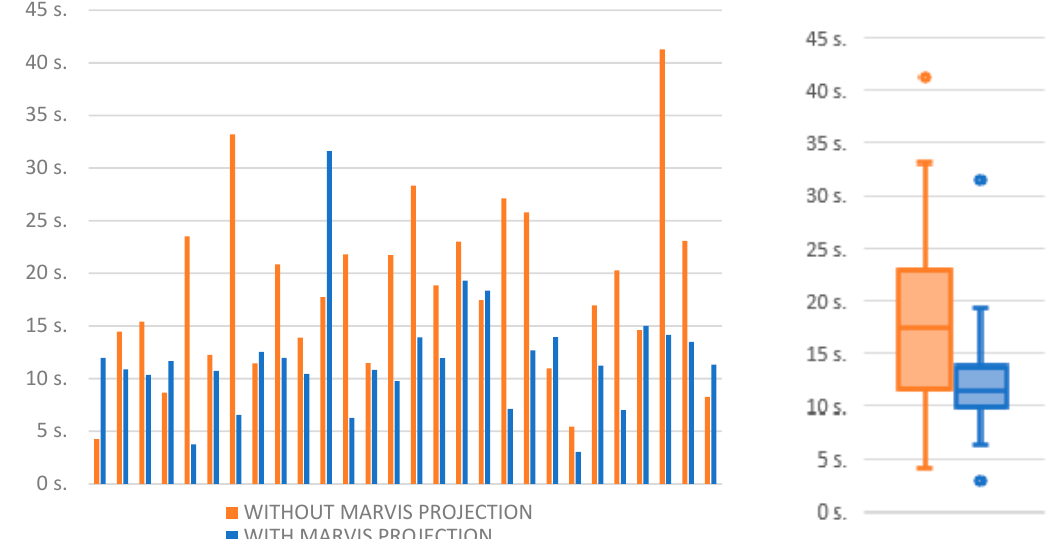
Figure 17. Median time of a correct prick for each participant (on the left ); a box-and-whisker diagram presenting the distribution of the values (on the right ). The band in the box presents the median value for all participants. The boxes present the first and third quartiles while the ends of the whiskers show the minimal and maximal values without outliers in the group. Data points for which the distance to the box exceeds 1.5 of the interquartile range are marked as outliers.